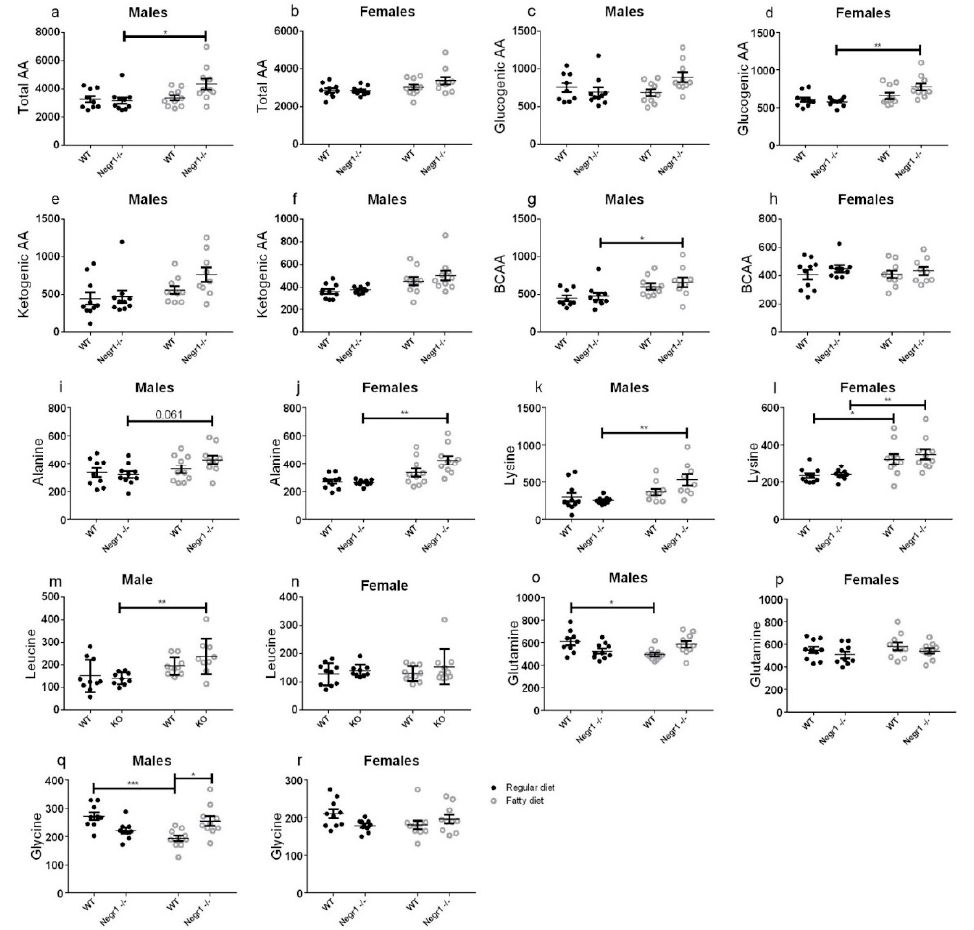
Figure 5. Effect of HF diet on the level of amino acids. In WT animals the HF diet had limited effect on serum amino acid levels. In Negr1 − / − animals the HF diet increased the total pool of amino acids in blood. The level of ( a , b ) Total AA, ( c , d ) Glucogenic AA, ( e , f ) Ketogenic AA and ( g , h ) BCAA. ( i – r ) The level of different amino acids. Data represent mean ± SEM, * p ≥ 0.05, ** p ≥ 0.01, *** p ≥ 0.001, two-way ANOVA (Bonferroni post hoc